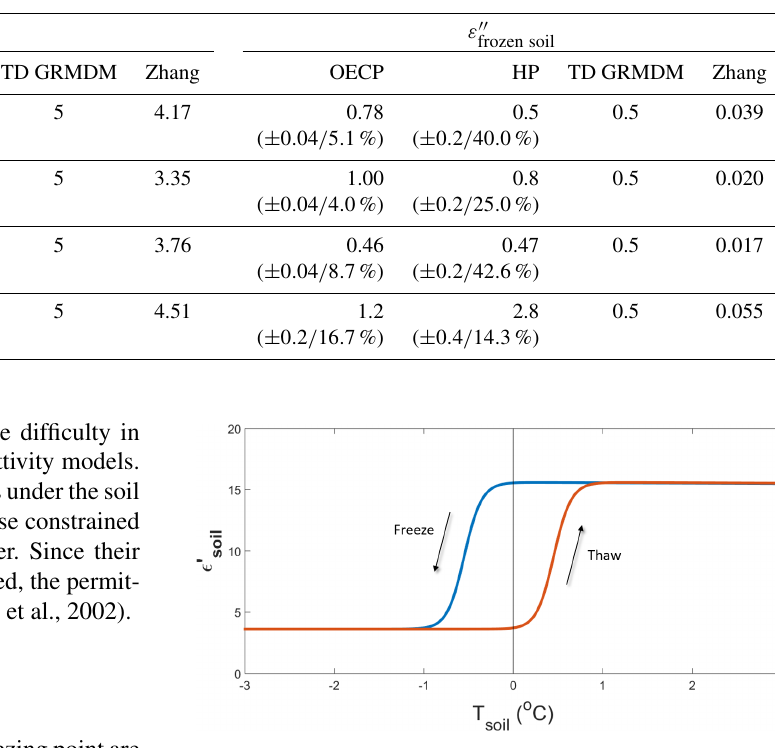
Figure 10. Expected hysteresis effect between freeze and thaw cy- cles. This theoretical curve was produced using an adapted version of Zhang’s model and the soil composition of the OBS